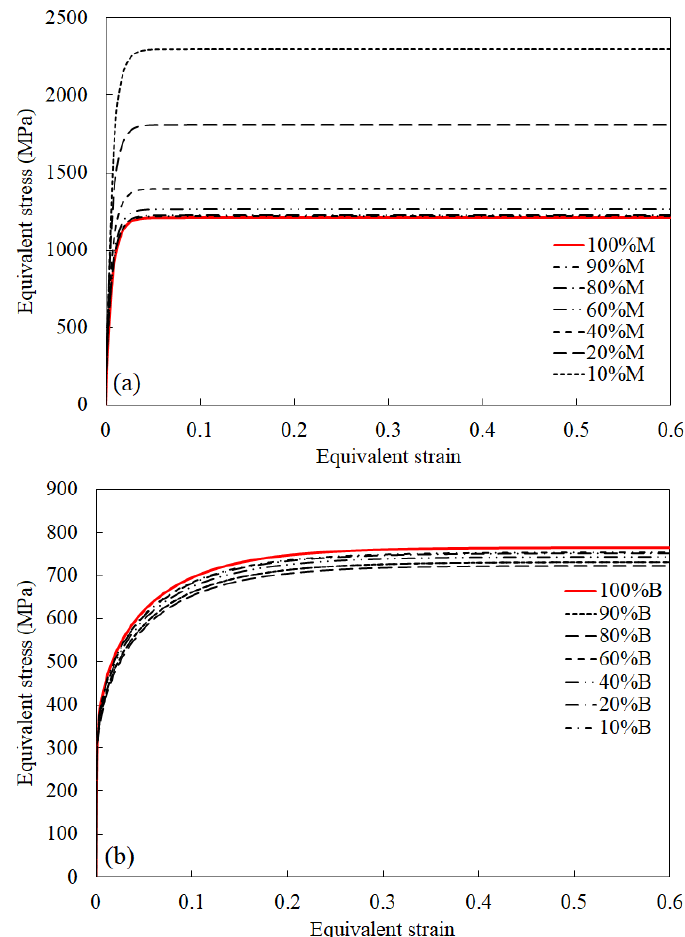
Figure 17. The calculated hardening curves for ( a ) martensite and ( b ) bainite in Ductibor ® 1000- AS bainitic-martensitic microstructures with various phase amounts (%v) using Rodriguez and Gutierrez’s model (Equation (8)